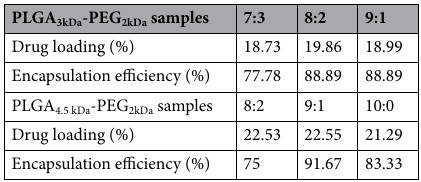
Table 1. Final results of drug entrapments in the simulated